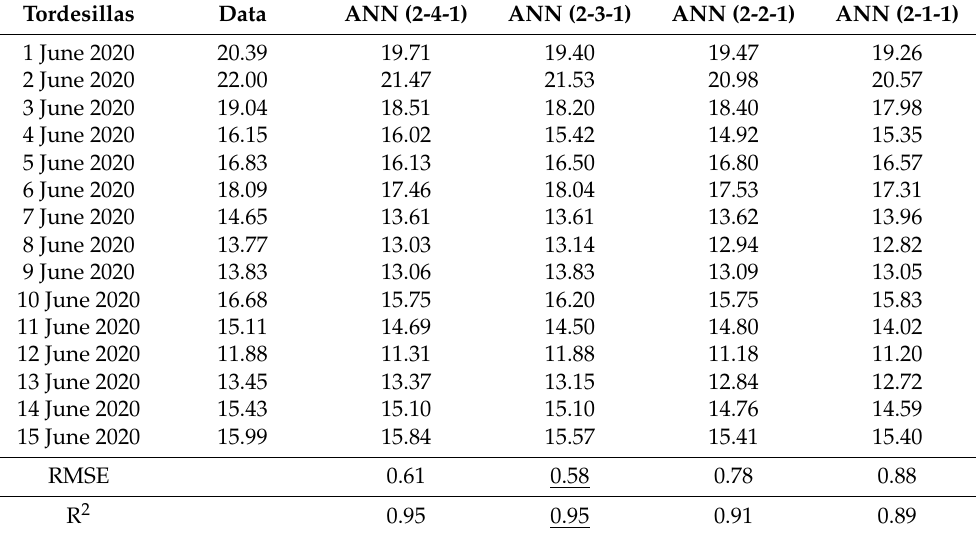
Table 3. Daily average temperature ( ◦ C) in Tordesillas (Valladolid) measured for 15 days (i.e., 1–15 June 2020), estimation performed with the neural architectures varying the number of neurons from four to one in the hidden layer (i.e., ANN (2-4-1), ANN (2-3-1), ANN (2-2-1) and ANN (2-1-1)), and fitting of the